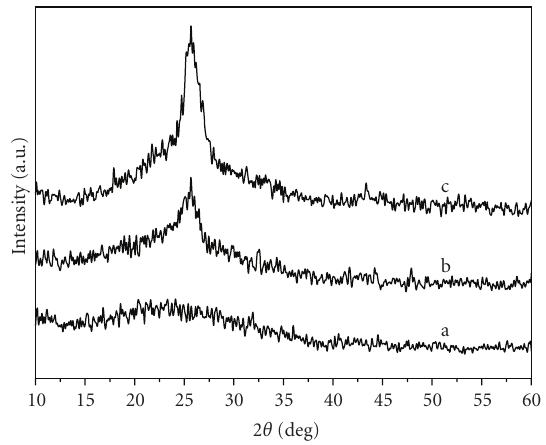
Figure 2: XRD patterns of (a) pure PEDOT:PSS, (b) M- PEDOT:PSS (0.1wt%), and (c) MWCNTs